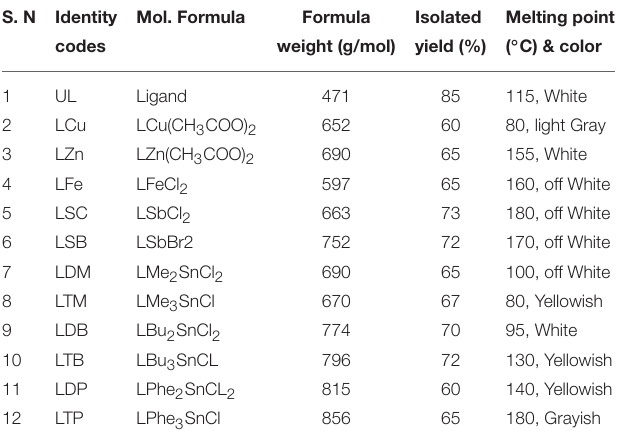
TABLE 1 | Physical data of ligand and their metal complexes. S. N Identity Mol.